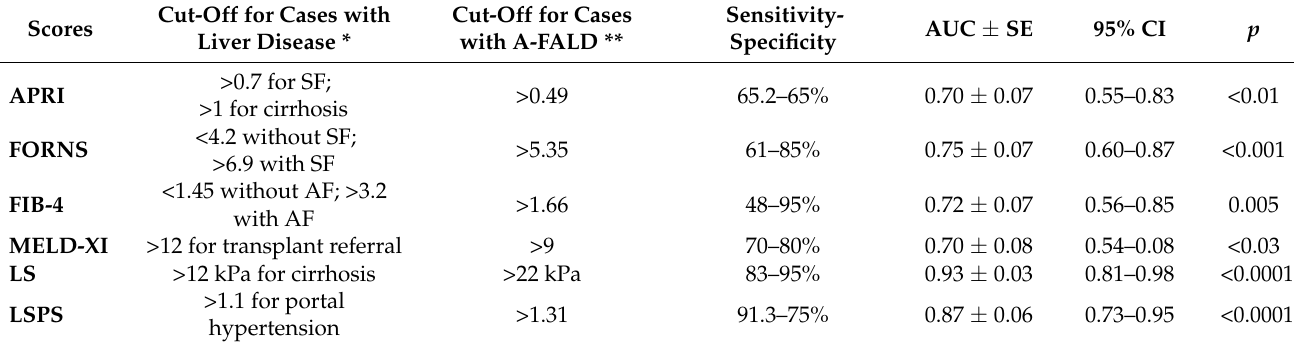
Table 2. Cut-offs and indexes of diagnostic accuracy among LS and conventional scores used for prediction of liver disease and for identification of cases with advanced